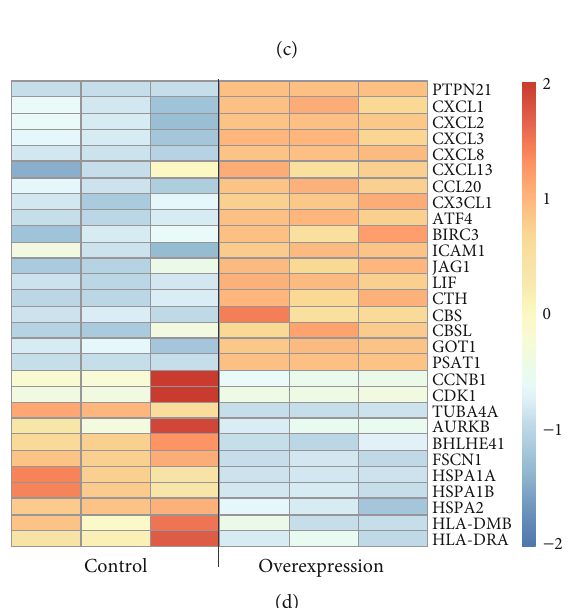
Figure 8: Analysis of transcriptome data in the control and overexpression BM-MSCs. (a) Heat map of DEG cluster. The expression levels of 435 genes change signi fi cantly in the overexpression group compared to the control group ( p ≤ 0 : 001 , ð ∣ log2FC ∣ Þ ≥ 1 ). Of these, 282 are commonly upregulated and 153 are commonly downregulated. (b) GO analysis of DEGs. Selected signi fi cant ontology terms are shown. The blue-colored columns indicate downregulation genes, while the orange-colored columns indicate upregulation genes. (c) GSEA analyses of gene expression pro fi le in overexpression versus control cells. The normalized enrichment score (NES) and p values are shown. (d) Heat map of enriched DEGs between two groups is shown. APP : antigen processing and presentation via MHC class MHCII